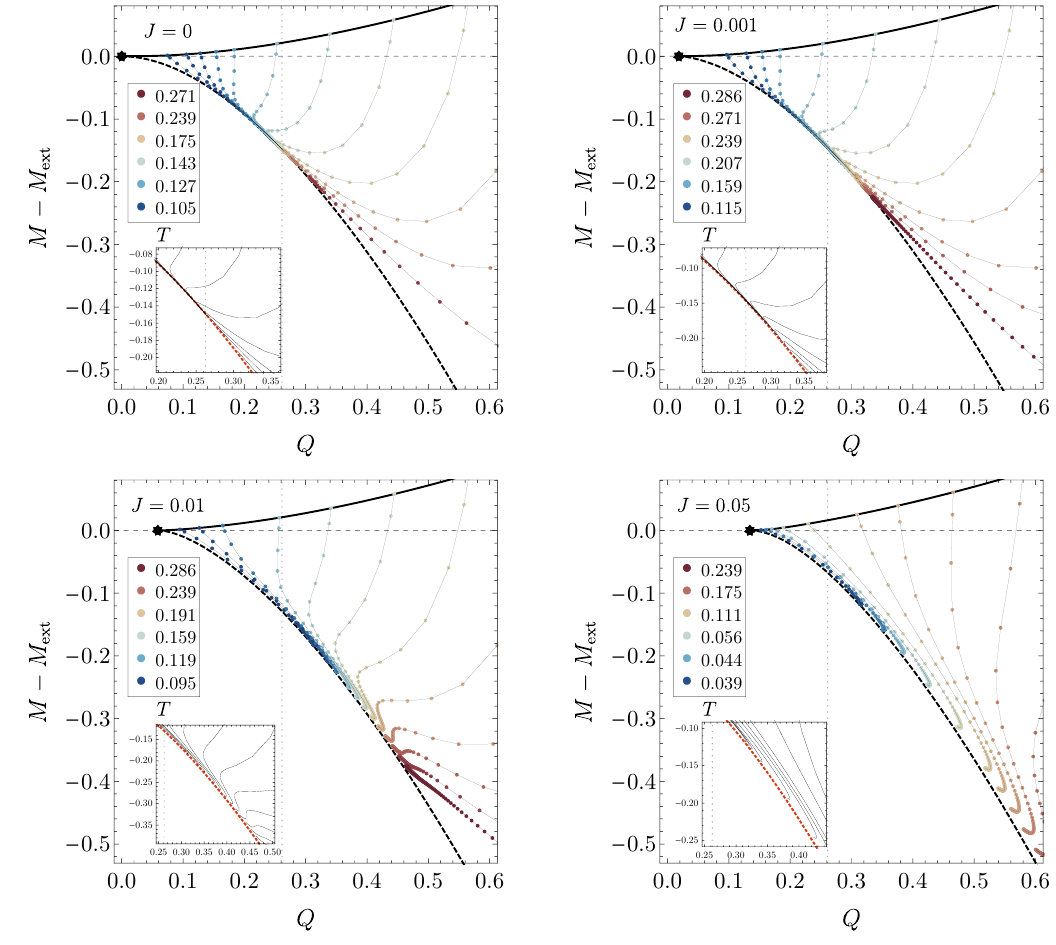
Figure 11 . Rotating hairy black holes at (cid:12)xed temperature, for di(cid:11)erent (cid:12)xed angular momenta J = 0 ; 0 : 001 ; 0 : 01 ; 0 : 05, while varying the horizon scalar (cid:12)eld " H . We plot the mass di(cid:11)erence M (cid:0) M ext against the charge Q , where M ext is the mass of the corresponding extremal CLP black hole. The solid black line is the scalar instability curve, dashed black line (or red line in the insets) is the BPS bound, black star is the Gutowski-Reall black hole. The vertical dotted line shows the special soliton Q max ( J = 0) = Q c . Insets zoom around interesting isotherm behaviour. \swallowtail" phase transitions in the canonical ensemble (to be discussed in section